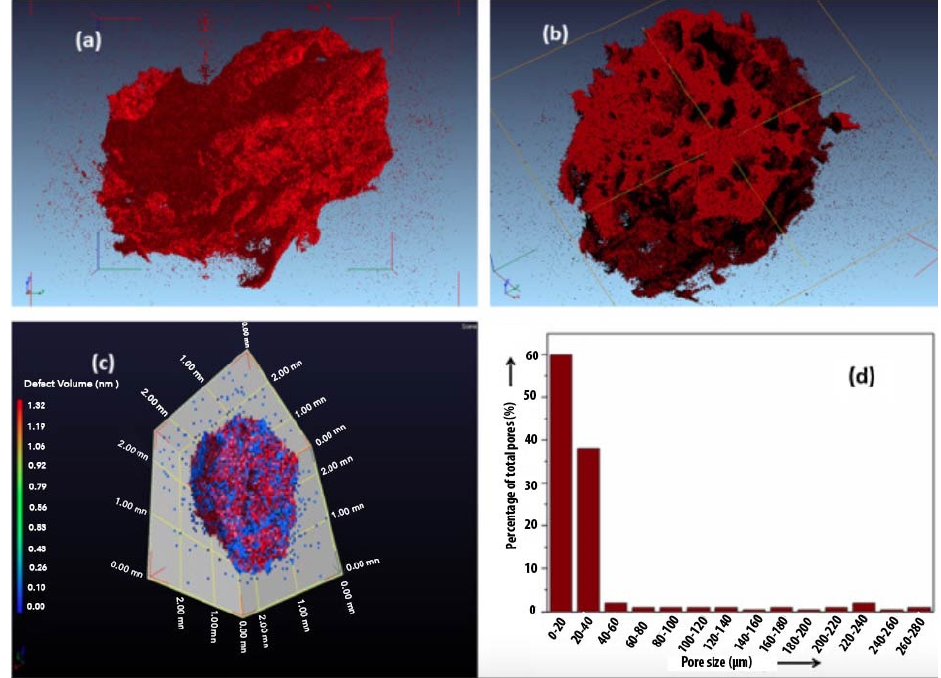
Figure 4. Micro-CT images: ( a ) side view, ( b ) cross-sectional view of ( c ) defect volume analysis for Figure 4. Micro-CTimages: ( a )sideview,( b )cross-sectionalviewof( c )defectvolumeanalysisforestimation estimation of porosity. ( d ) Pore size distribution of C (0.1%). (Reprinted with permission from ofporosity. ( d )PoresizedistributionofC(0.1%).(Reprinted with permission from Carbohydrate